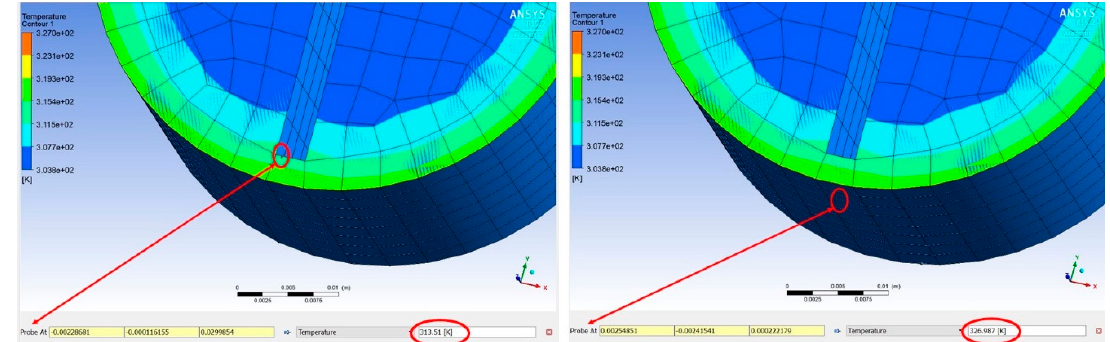
Figure 8. Temperature nephogram at specific points inside and outside of the sample during the heat treatment